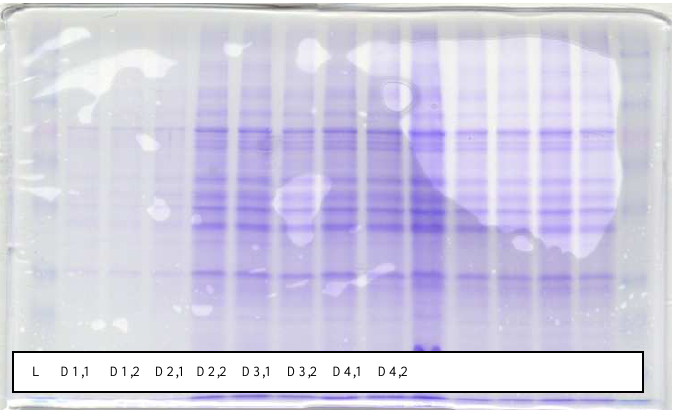
Figure 2. SDS gel showing overtime distribution of protein in the supernatant over a period of 7 days . L is the loading buffer used on a 12.5% gel. D1,1 and D1,2 represent morning and afternoon samples on the first day, D2,1 and D2,2 represent morning and afternoon samples on the second day, D3,1 and D3,2 represent morning and afternoon samples on the third day...and so on. Since the microorganisms reached their log phase after the 4 th day, the continuous protein release into the culture solution (D4 to D7) was probably due to cell lysis.